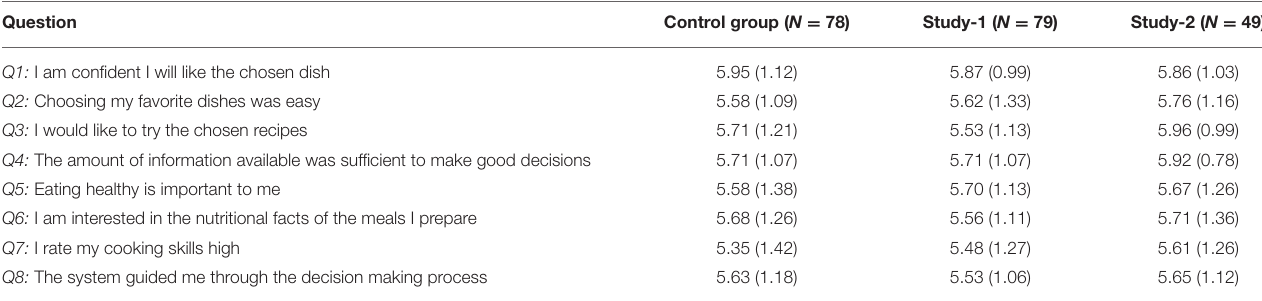
Table A1 | Mean answer given in the final questionnaire decision.